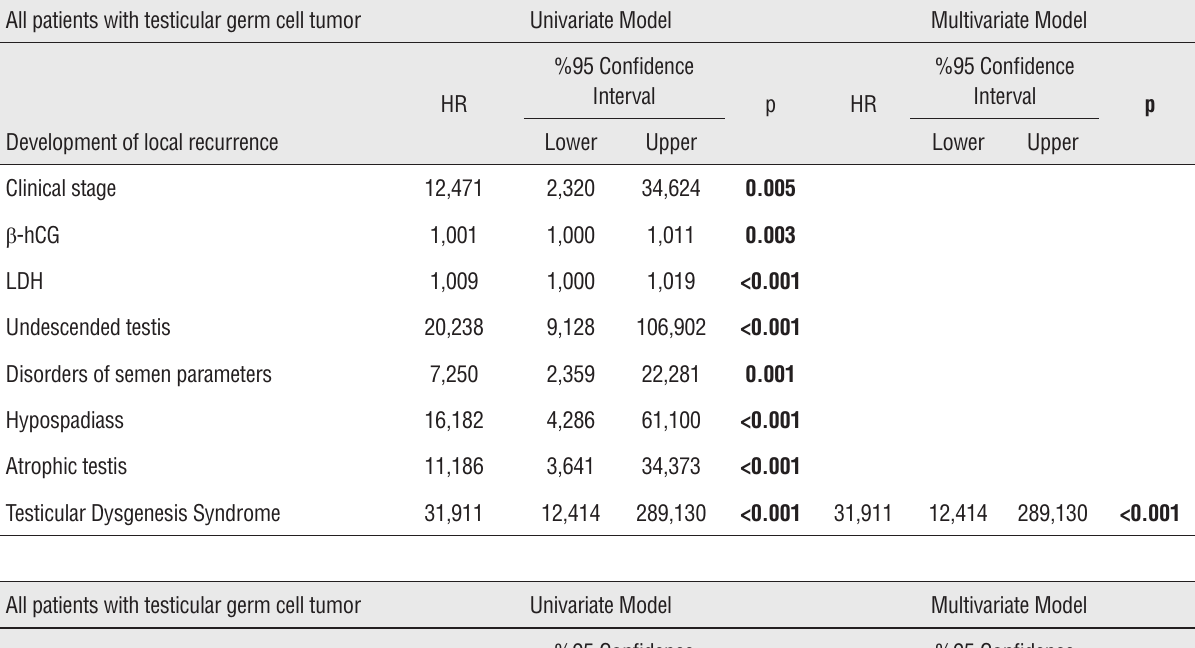
Table 4 - Predictive factors for local recurrence, distant metastases and cancer-specific survival. All patients with testicular germ cell